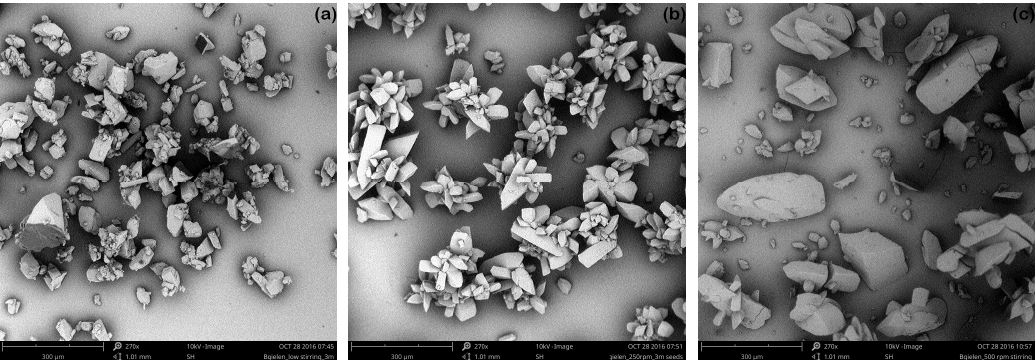
Figure 6. Effect of stirring rate on degree of agglomeration after seeding at a temperature of 62 °C: ( a ) 3 m% milled seeds, no stirring; ( b ) 3 m% milled seeds, 250 rpm; and ( c ) 0.2 m% seeds, 500 rpm. All SEM images were magnified 270 times and the scale bar represents a length of 300 µm.